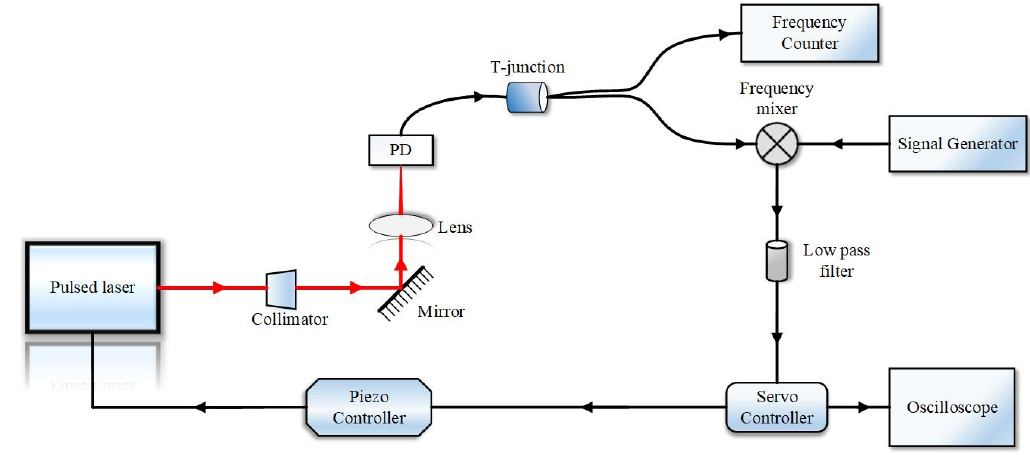
Figure 1. Locking scheme of the repetition frequency. PD: photodetector.